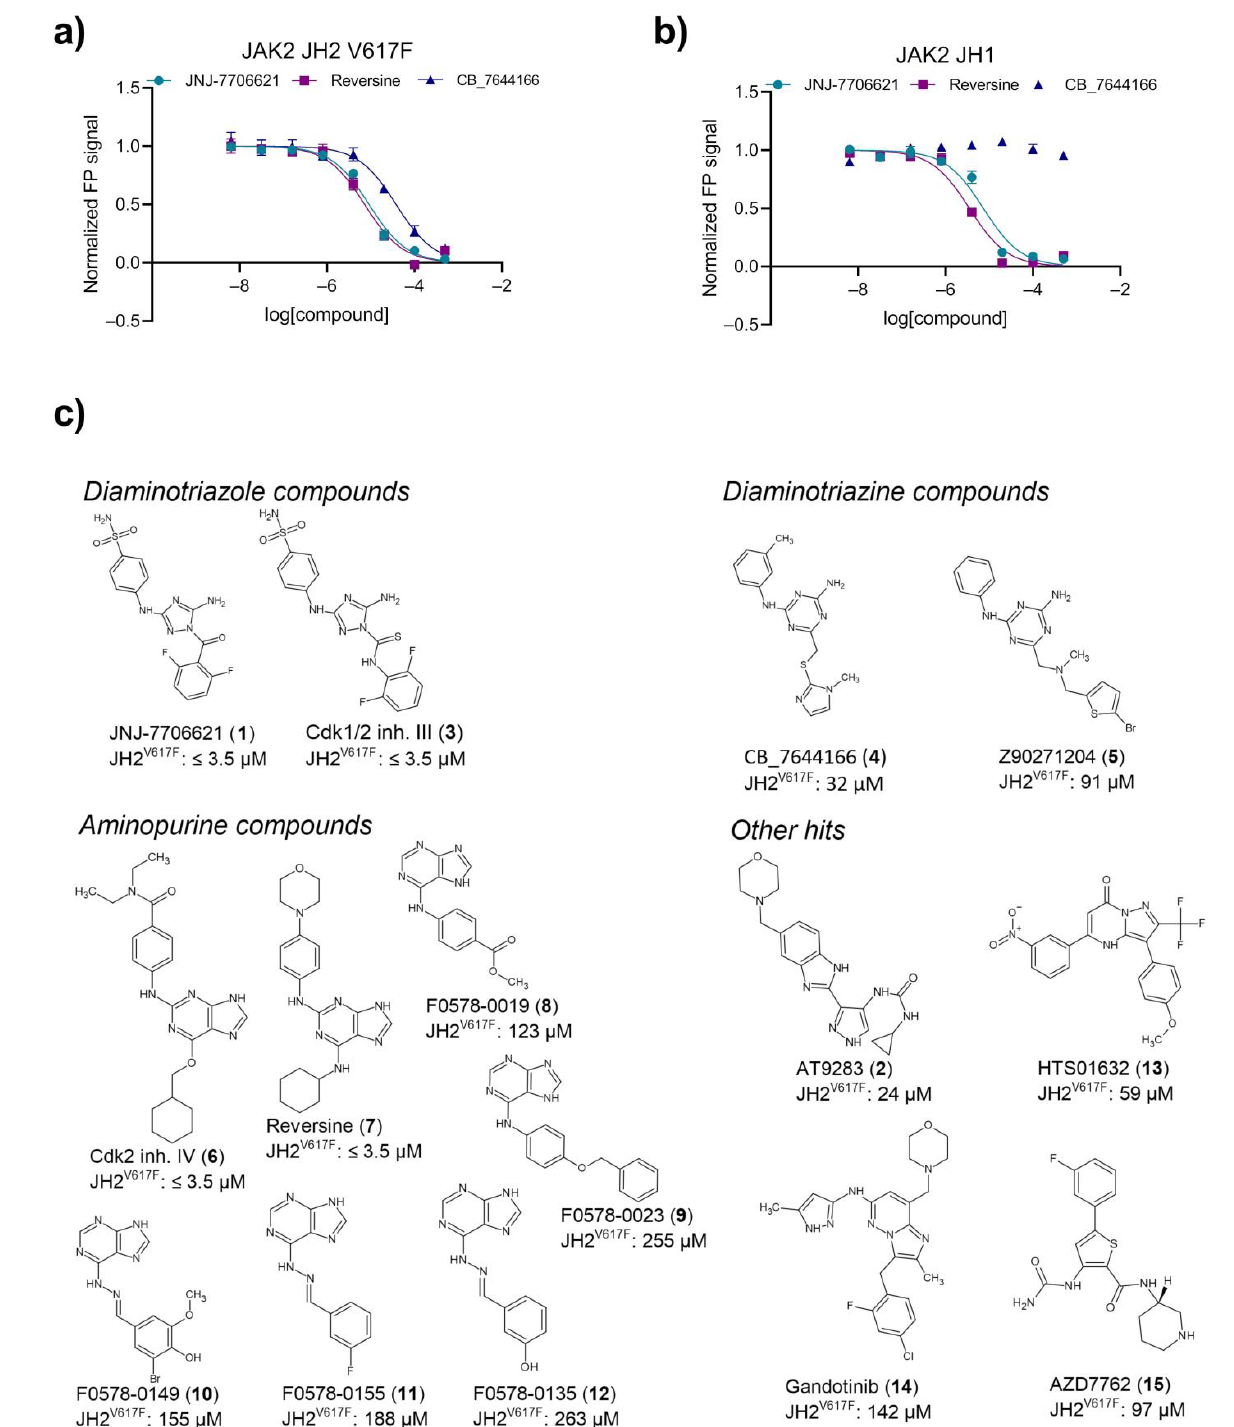
Figure 2. Dose-response data and chemical structures of selected hits. ( a ) Normalized dose–response data JNJ-7706621 ( 1 ), reversine ( 7 ), CB_7644166 ( 4 ) from fluorescence polarization assay for recombinant JAK2 JH2 V617F. Binding of compounds in ATP pocket of proteins is observed as signal decrease. ( b ) Normalized dose–response data JNJ-7706621 ( 1 ), reversine ( 7 ), CB_7644166 ( 4 ) from fluorescence polarization assay for recombinant JAK2 JH1. ( c ) Chemical structure and IC50 value for binding against JAK2 JH2 V617F of confirmed hits. Hits were grouped based on chemical structure as diaminotriazole compounds, diaminotriazine compounds, aminopurine compounds, and other